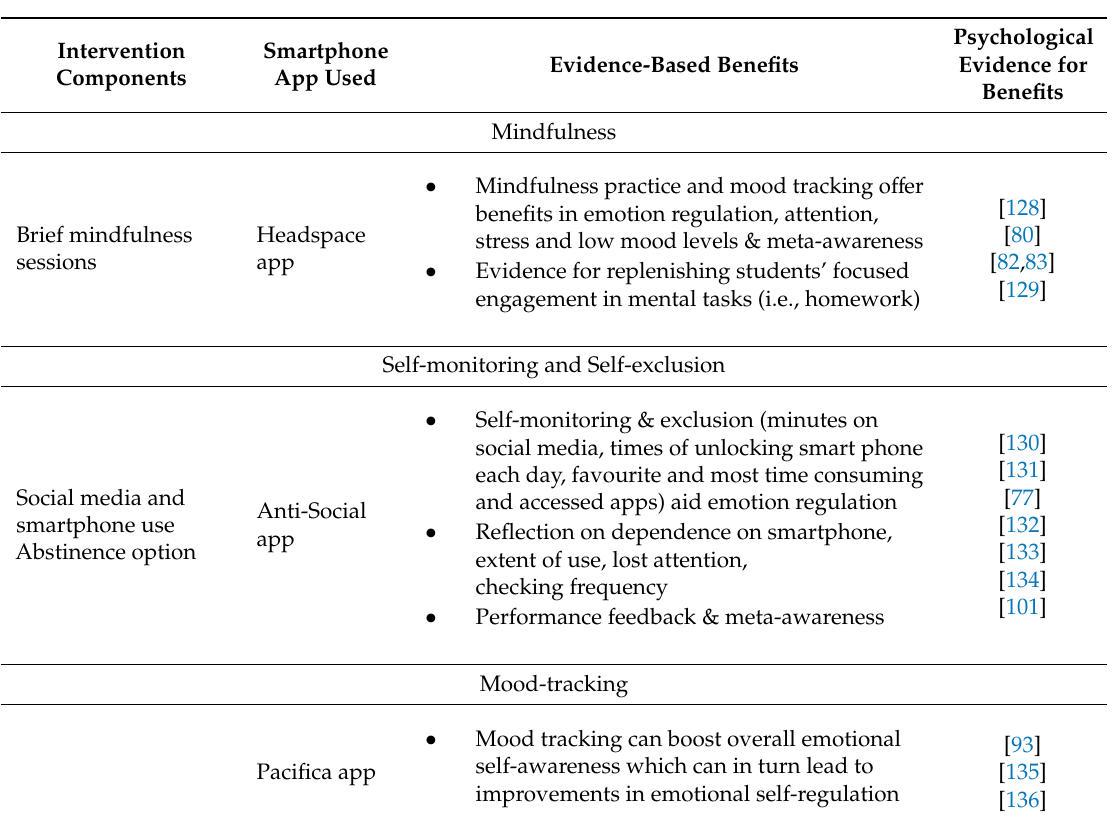
Table 1. The three components of the